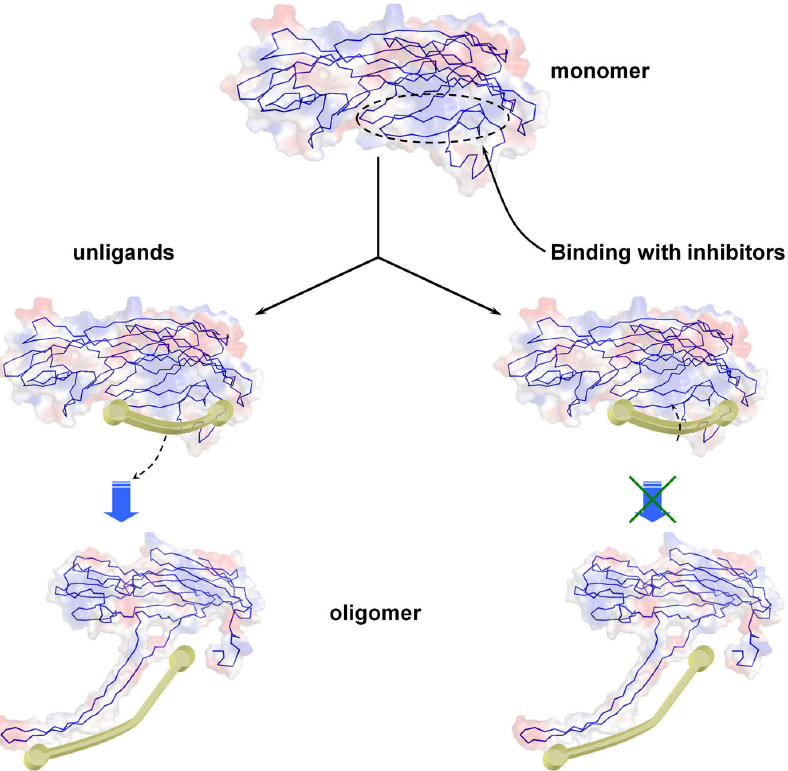
Figure 9. OLG (A), ORA (B) and ORB (C) prevent the deoxycholate-induced oligomerization of a -HL. a -HL was treated with 5 mM deoxycholate in the presence or absence ligands. Following sodium dodecyl sulfate (SDS)-polyacrylamide gel electrophoresis (PAGE) analysis, the proteins were detected by silver staining. (A) Lane 1, WT-HL; lane 2, R104A-HL; lane 3, G126A-HL; lane 4, WT-HL plus 2 m g/ml of OLG; lane 5, R104A-HL plus 2 m g/ml of OLG; lane 6, G126A-HL plus 2 m g/ml of OLG. (B) Lane 1, WT-HL; lane 2, R104A-HL; lane 3, G126A-HL; lane 4, WT-HL plus 16 m g/ml of ORA; lane 5, R104A-HL plus 16 m g/ml of ORA; lane 6, G126A-HL plus 16 m g/ml of ORA. (C) Lane 1, WT-HL; lane 2, R104A-HL; lane 3, G126A-HL; lane 4, WT-HL plus 32 m g/ml of ORB; lane 5, R104A-HL plus 32 m g/ml of ORB; lane 6, G126A-HL plus 32 m g/ml of